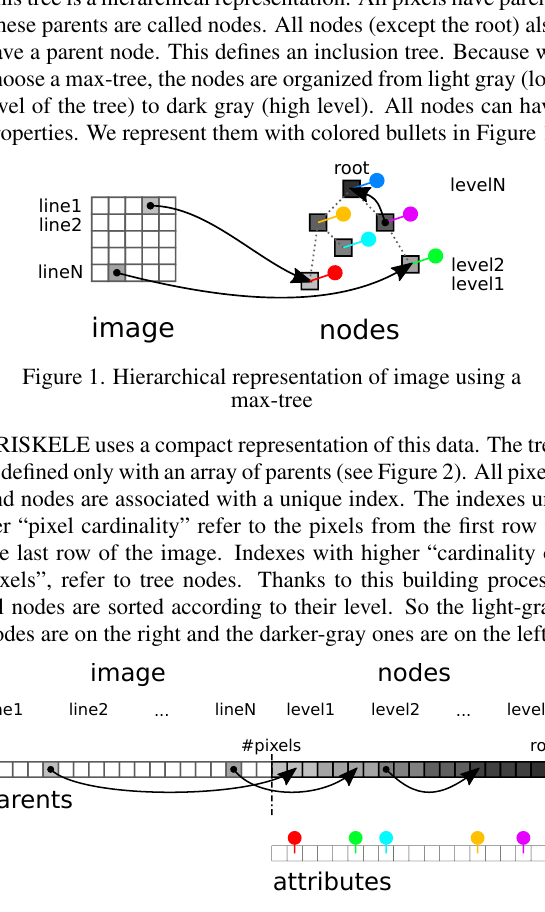
Figure 2. Tree implemented with array Attributes are only defined for nodes. The attributes can be simple scalar (surface, perimeter, gray value) or multivalued (centroid, bounding box), and they are also stored in another array. The position of an attribute in an array gives the position of the associated node. Here are our efficient calculations of new